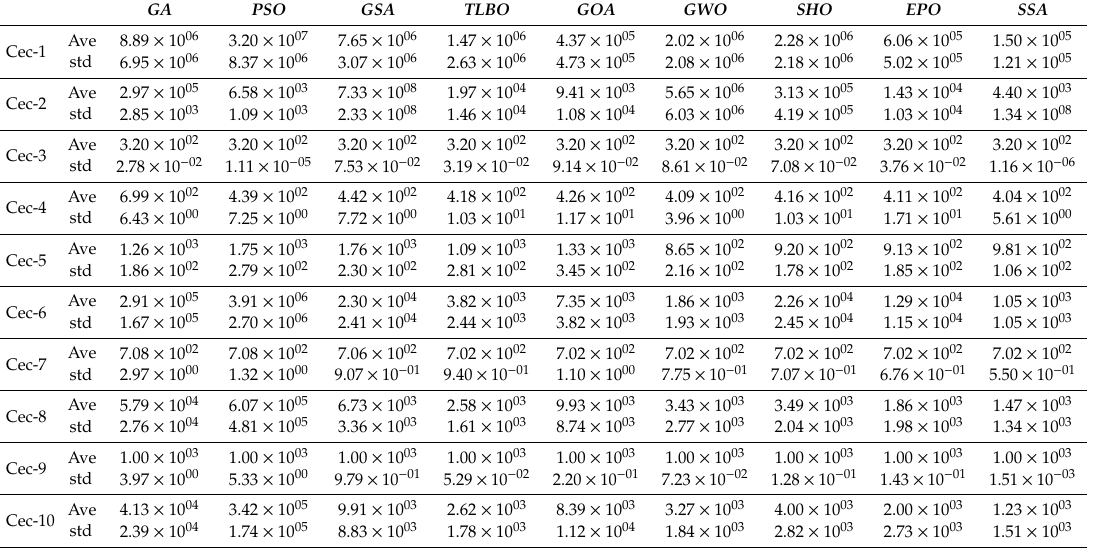
Table 4. Results for SSA and other algorithms in CEC